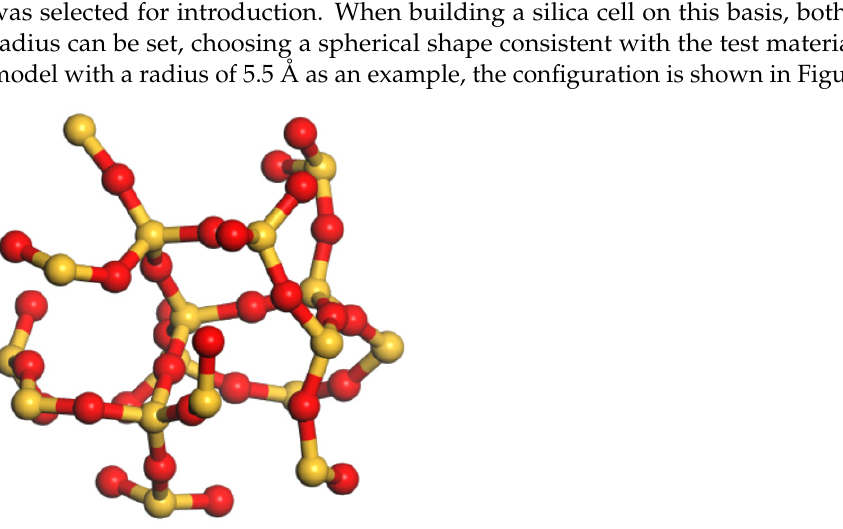
Figure 4. Radial distribution function (RDF) for distances of intra-molecular and inter-molecular atoms in asphalt molecular models.